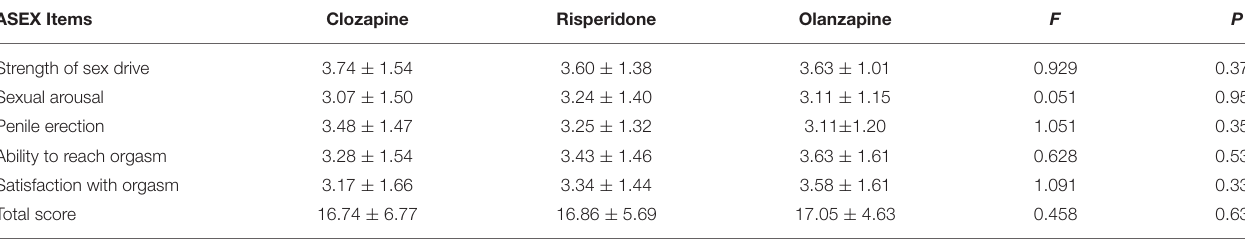
TABLE 3 | The effect of antipsychotics on sexual dysfunction ASEX.